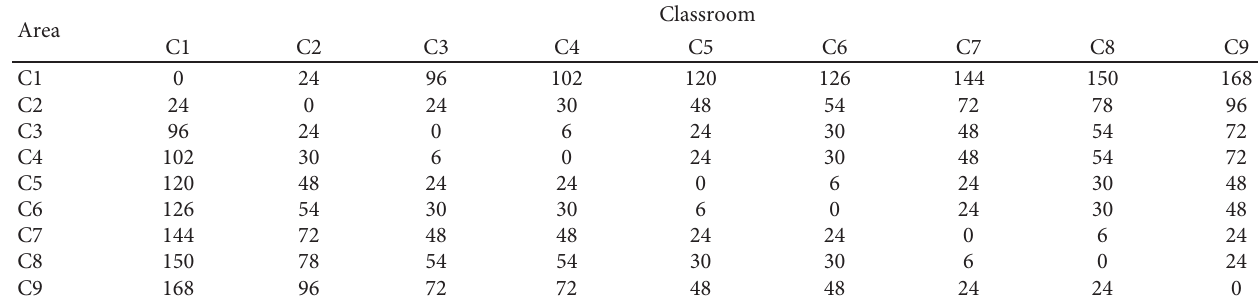
Table 14: Area between two